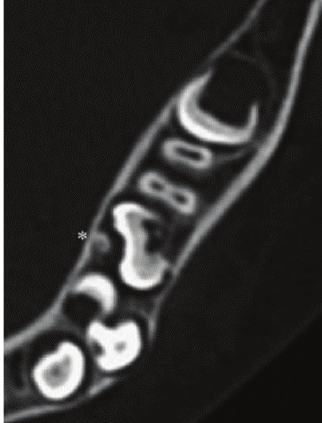
Figure 2: Axial computed tomography image: case 1. A small calcium deposit ( ∗ ) located lingual to the mandibular right second primary